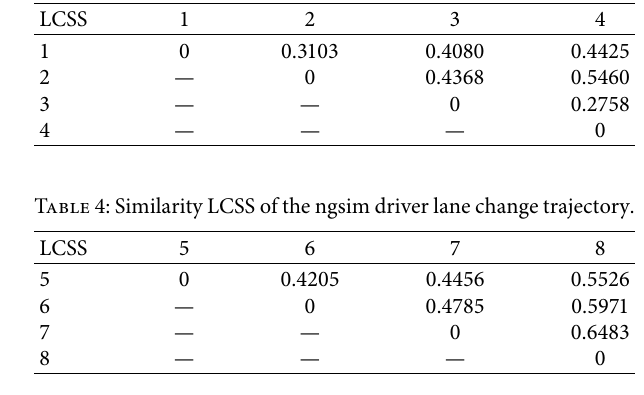
Table 3: Similarity LCSS of the skilled driver lane change trajectory.